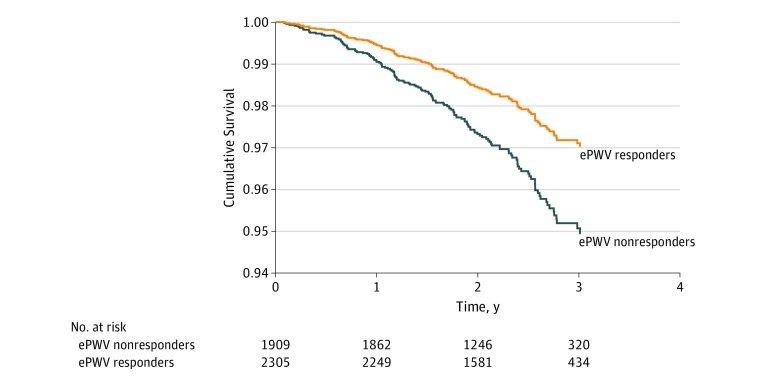
Effect of the Response of Estimated Pulse Wave Velocity (ePWV) to 12 Months of Treatment on All-Cause Death in the Standard Treatment GroupTime zero is 12 months after randomization. The hazard ratio for ePWV responders is 0.58 (95% CI, 0.36-0.94) (P = .03).